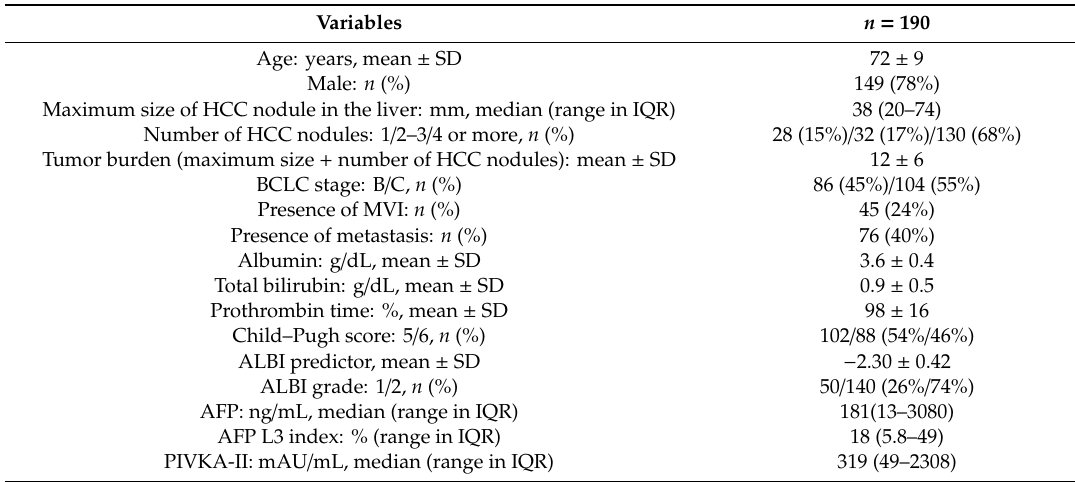
Table 1. Background of